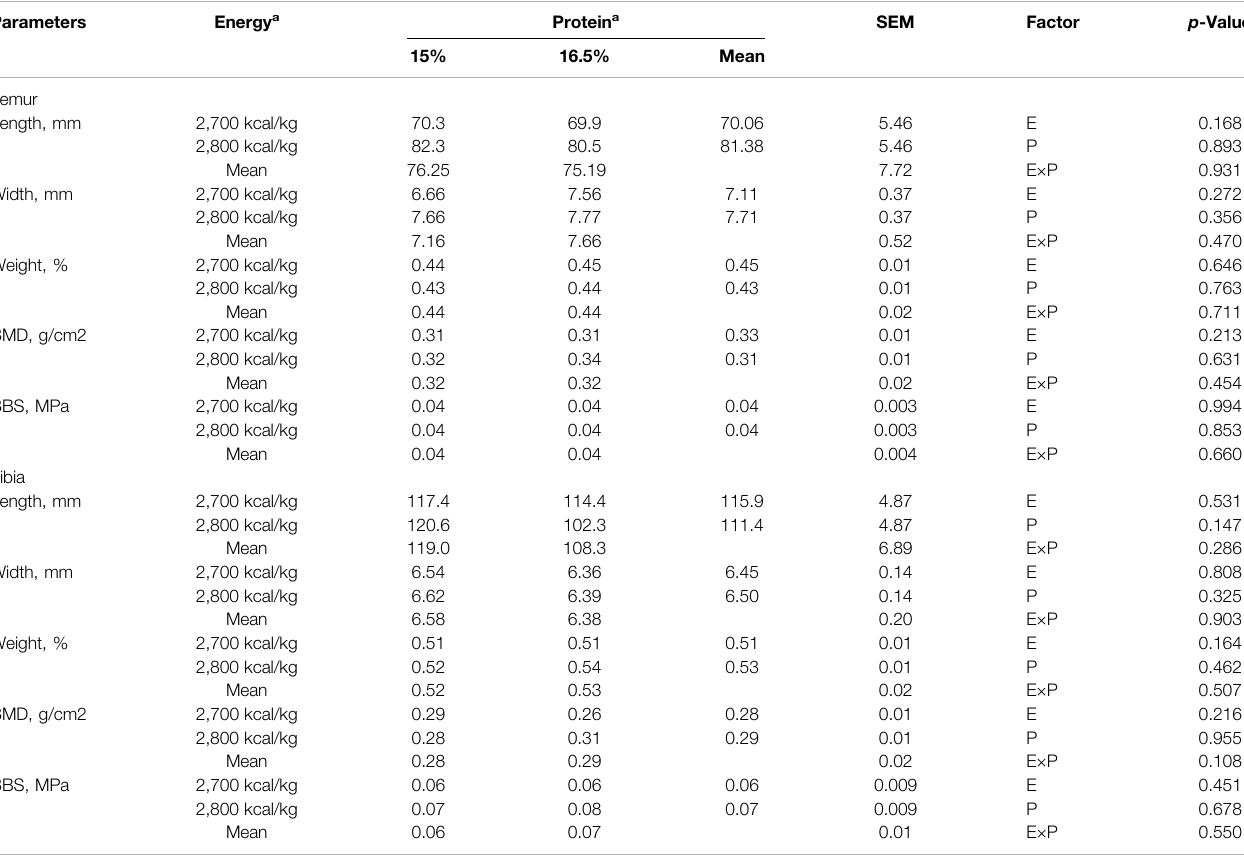
TABLE8| Effectofdietarymetabolizableenergy(E)andcrudeprotein(P)levelsduringtheprelayperiod(15 – 20 weeksofage)onboneparametersinlayinghensat72 week of age.